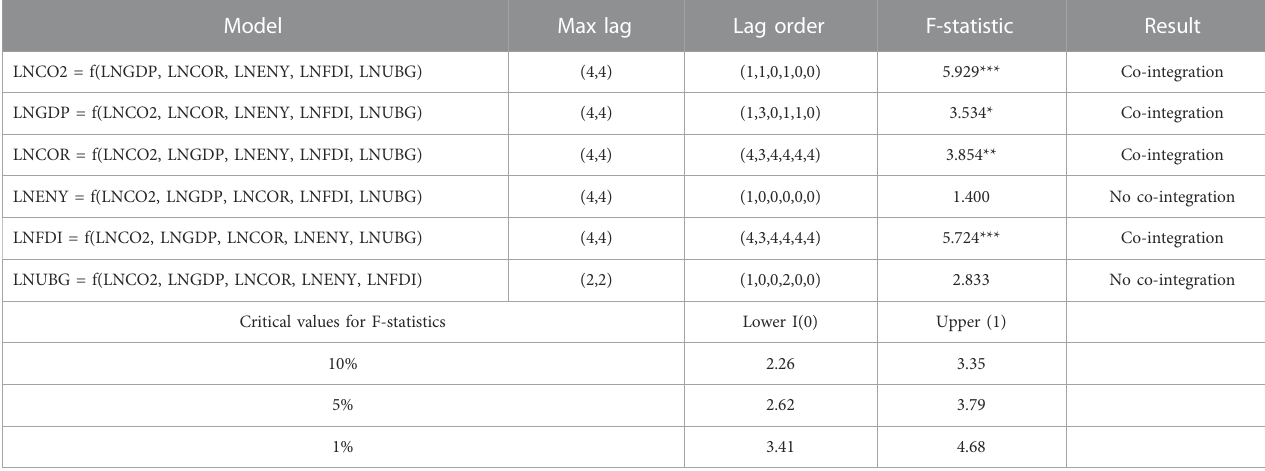
TABLE 4 Detecting the presence of long-run co-integration based on